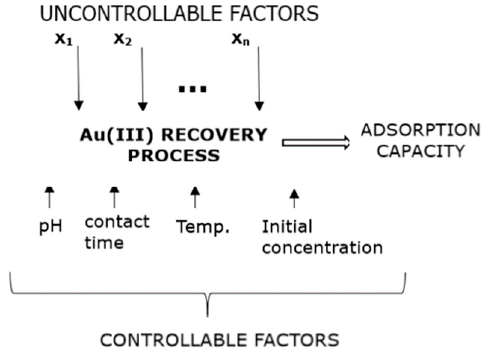
Figure 1. Adsorption process